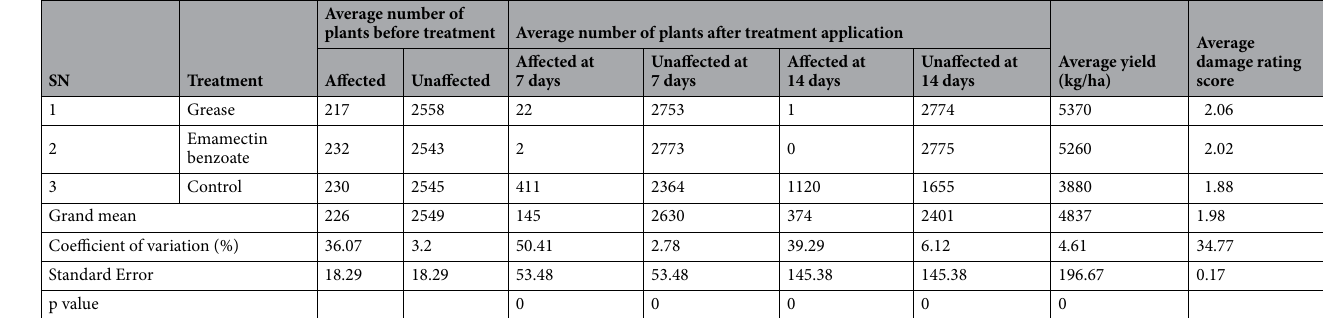
Table 2. Analysis of variance shows average grain yield, damage rating score, and number of affected and unaffected maize plants after the application of grease and emamectin benzoate in experimental plots to control fall armyworm larvae in the winter seasons of 2019/2020. ANOVA was calculated based on three treatments with five replications. Two number after decimal is reduced to a single digit. P value calculated at 0.05% level of